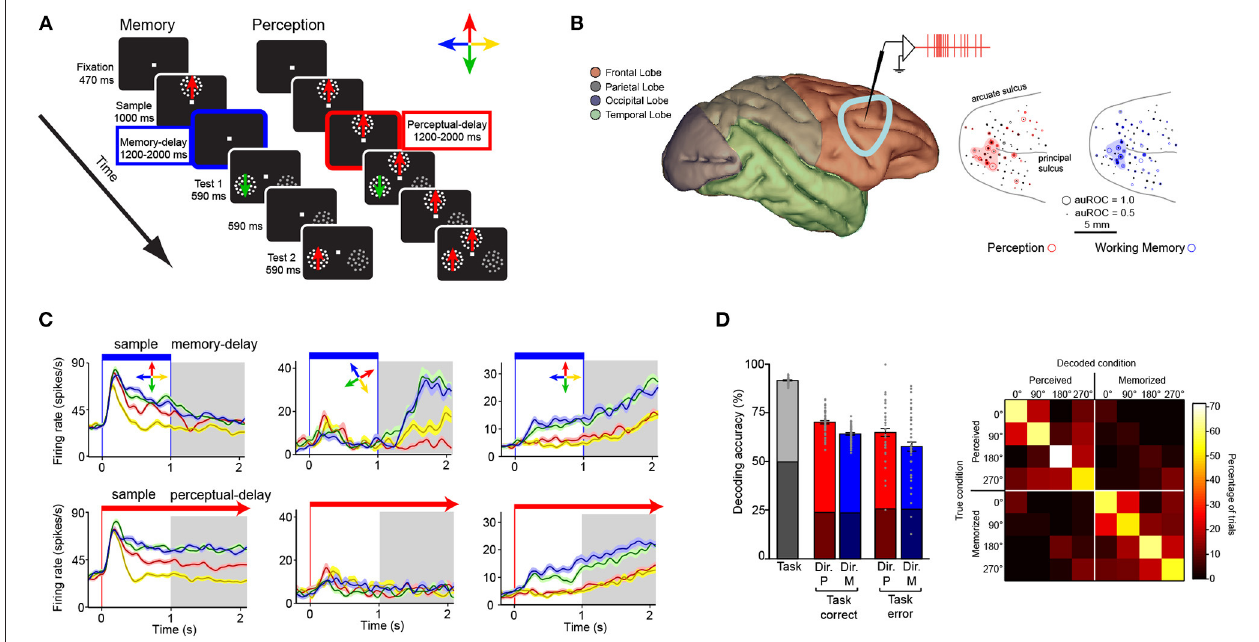
FIGURE 3 | Encoding of perceptual and working memory representations by subpopulations of neurons within the LPFC. (A) Memory and perception tasks. Panels illustrate stimuli and monitor setup. Animals fixate a dot at the center of a computer screen and press a button. Then a sample Random Dot Pattern (RDP) appears moving in one of four directions. In the memory task (left) the sample disappears after 1,000ms. A delay period of 1,200 to 2,000ms then occurs in which only the fixation point is on the screen. At the end of the delay period two patterns, a test RDP moving in either the same or different direction as the sample, and a distracter RDP that contains dots moving in random directions are presented. The animal releases a button if the test matches the direction of the sample or waits until the test disappears, and a second test RDP is presented after a 590-ms delay period. During the perceptual (right) task the sample RDP does not disappear but stays on during the duration of the trial. (B) Recording locations in the LPFC. The dots indicate the location of units with selectivity during the memory (blue) and perceptual (red) tasks. (C) Firing rate (y axis) over time (x axis) for three example neurons (left, center, and right columns) during the working memory task (top row) and perceptual task (bottom row). The task periods are indicated on top. (D) left bar graph: Accuracy of a linear classifier to decode, from the population of recorded neurons, the task (working memory vs. perceptual tasks, gray bar), the direction of the stimulus in each task in trials with correct and incorrect task decoding (red and blue bars). Right panel: confusion matrix for the classification of perceived and memorized direction corresponding to the correct